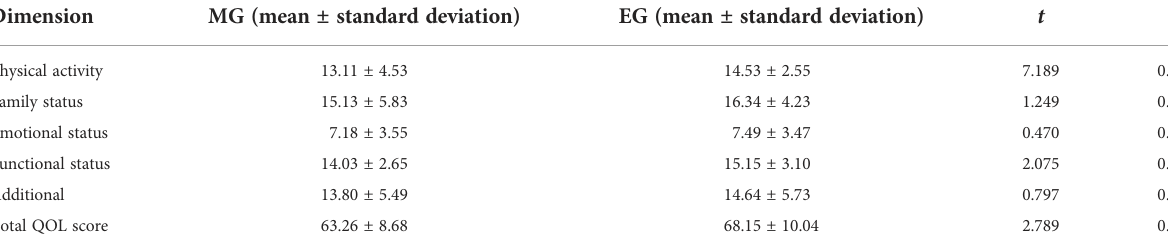
TABLE 7 Quality of life (QOL)